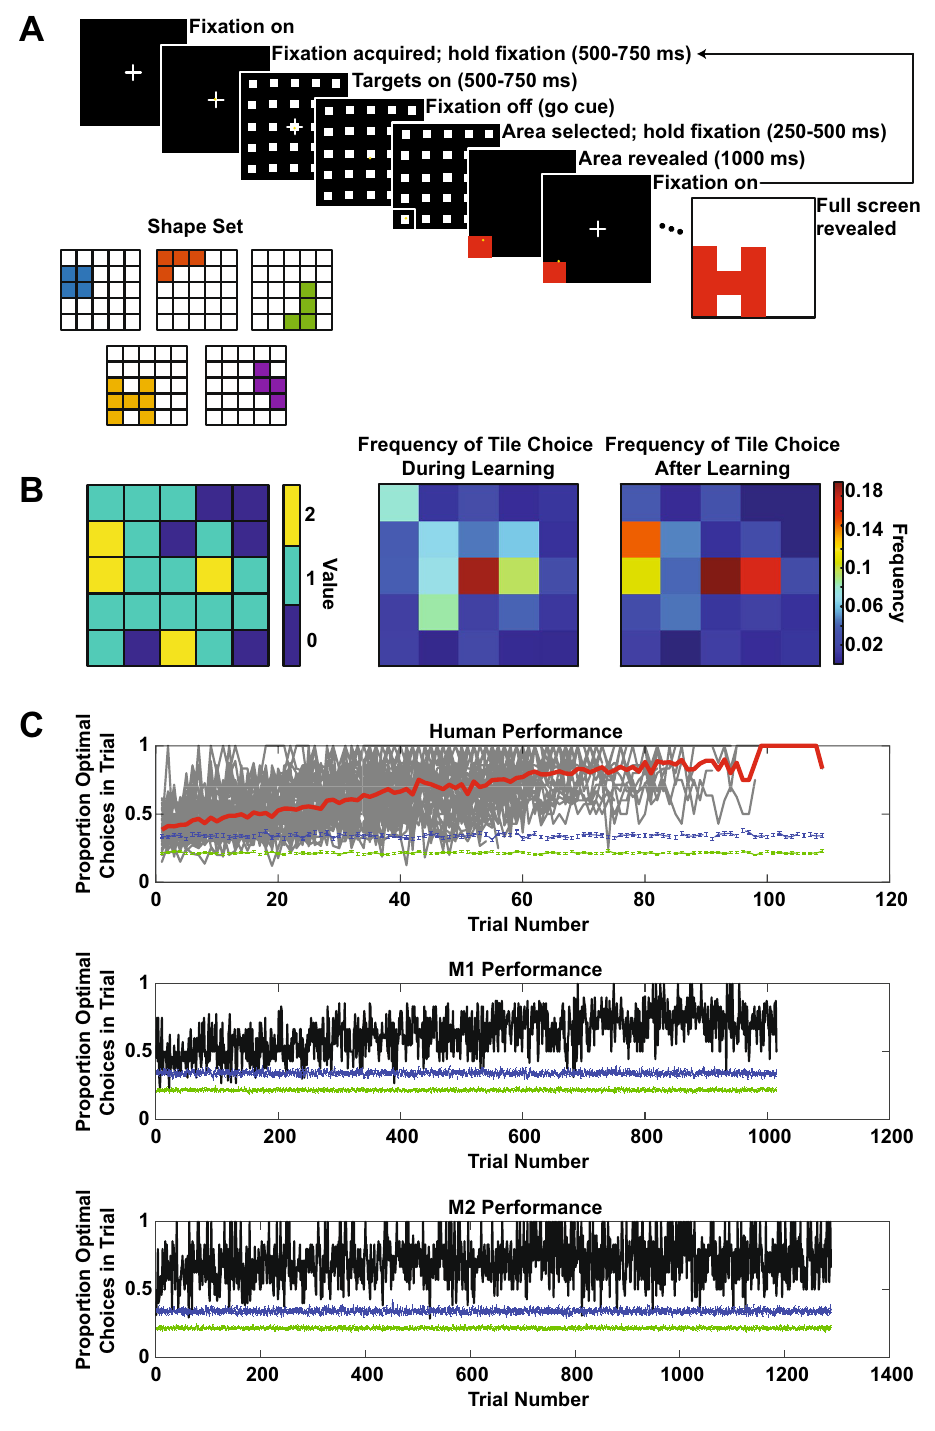
Figure 1. ( A ) Shape search task. The variable time intervals reported in the figure are for the monkeys; the human participants had fixed hold times of 500 ms for fixation, 500 ms after targets on, and 250 ms to register selection of a target. Inset: the five shapes used on the task. ( B ) Frequency of first tile choices across all subjects. Left panel: value map at the start of each trial; higher value tiles correspond to the tiles with more overlapping shapes. Middle: first-choice frequencies across all human participants (n = 42) during learning. Right: first- choice frequencies across all human participants after learning. See text for explanation. ( C ) Performance on the shape search task. Top panel: thick red line = average human performance, thin gray lines = individual subject traces; middle panel: M1; bottom panel: M2. For all three panels, jagged green line at bottom is the average performance of a choice algorithm that randomly chooses tiles (100 iterations), and jagged blue line at bottom is the average performance of a choice algorithm that randomly chooses tiles until a hit and then performs a local area search (100 iterations). Points are mean ±